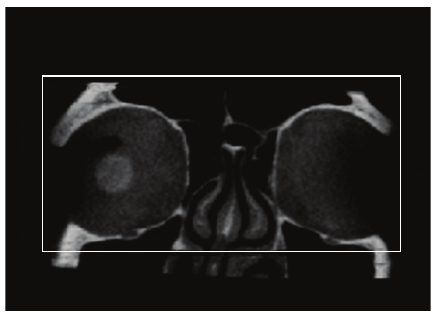
Figure 5: Multiplanar reconstruction (MPR) of the dedicated orbital volume (DV). Coronal view.